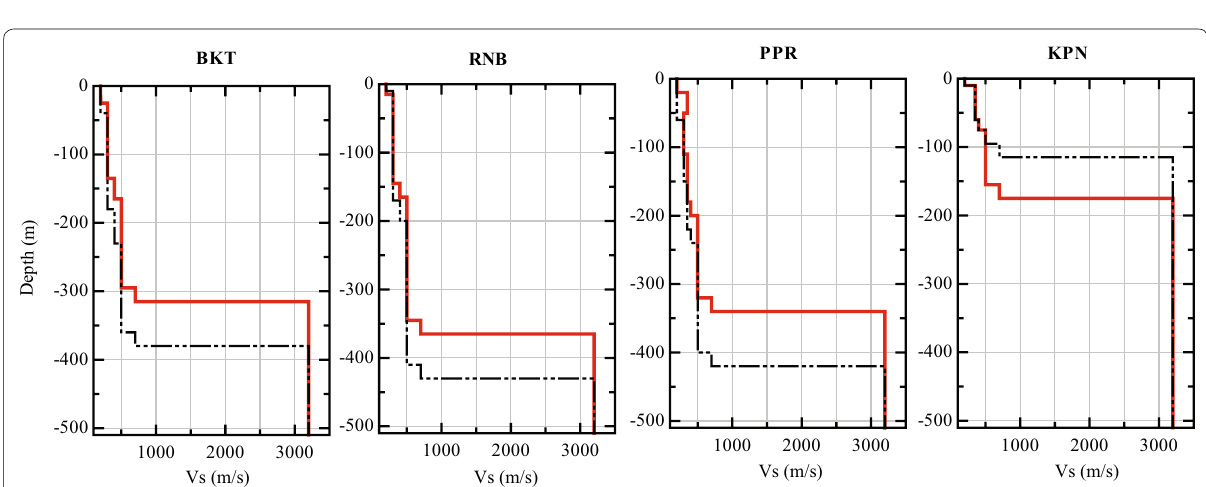
Fig. 13 1-D velocity models for the four temporary sites adjusted using the HVSR method. The site at KPN has the least sediment thickness, about 150 m. The dashed black lines show the initial velocity models for the four